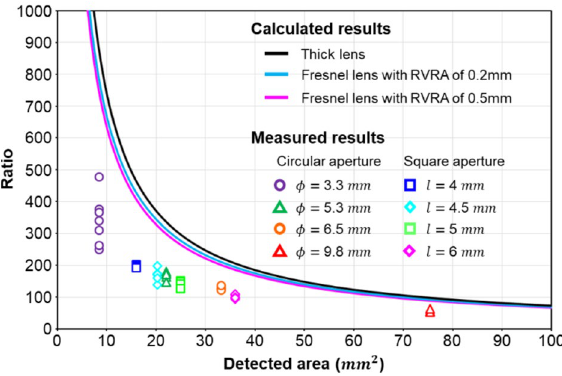
Figure 4. Fresnel lens performance measurements under sunlight. When the aperture size and shape were changed, the measurement was done under clear sunlight with Fresnel lens #1. The three curves show the related